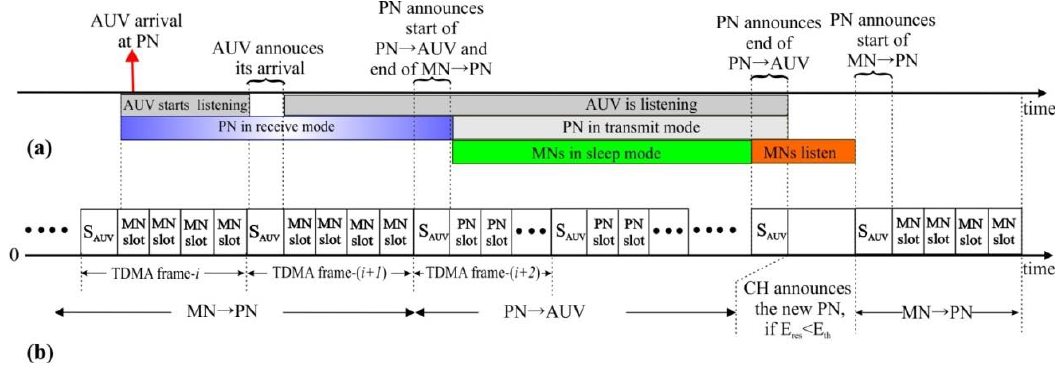
Figure 6. MN→PN and PN →AUV ( a ) communication related event ( b ) TDMA frame